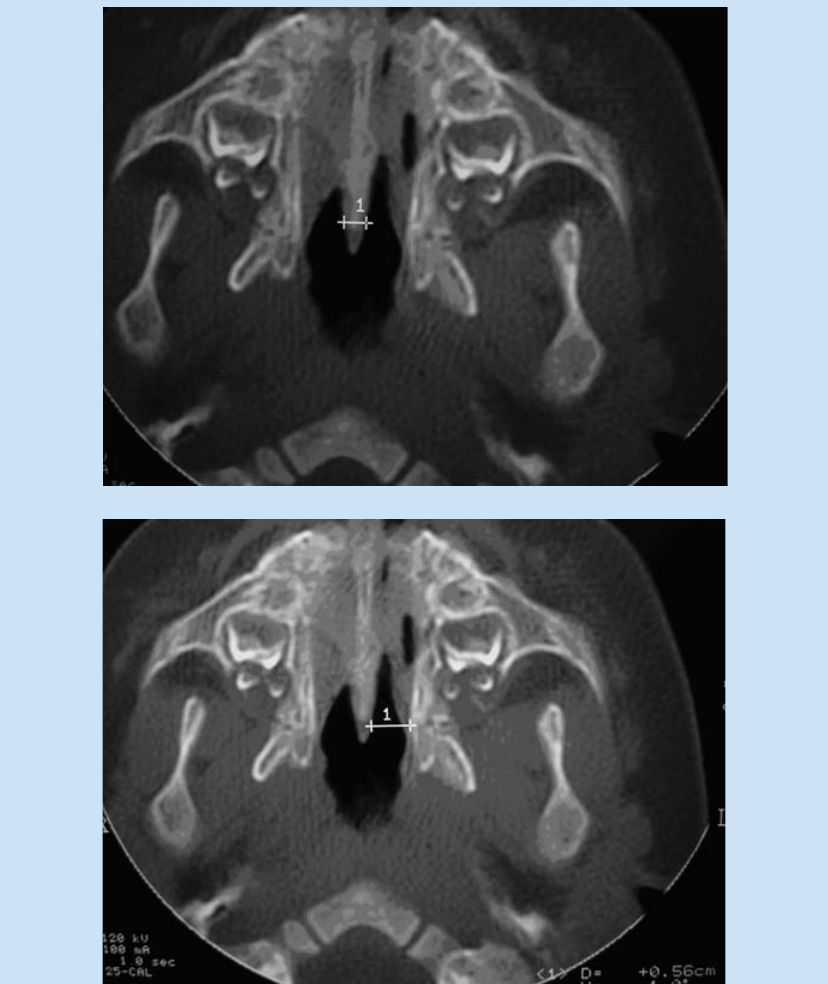
Figs 1 a and b. Normal scan at the level of the pterygoid plates. Note the paral- lel medial walls of the nasal cavity, the thin vomer and the wide posterior